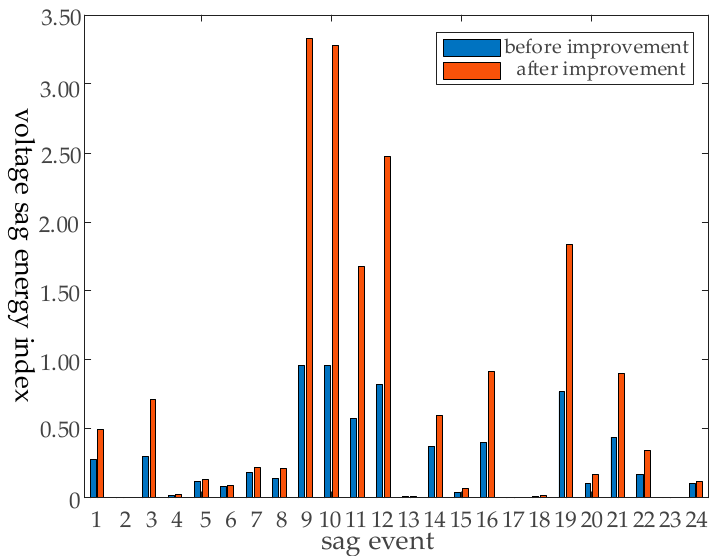
Figure 9. Comparison of voltage sag energy index before and after improvement.